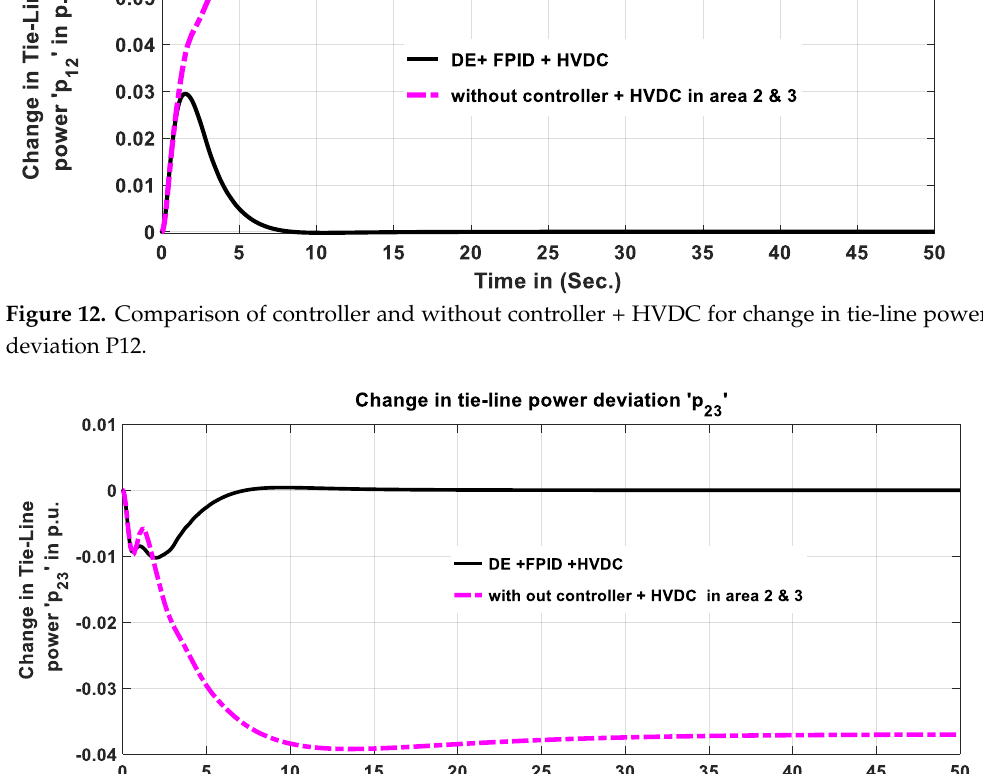
Figure 13. Comparison of controller and without controller + HVDC for change in tie-line power deviation P23.